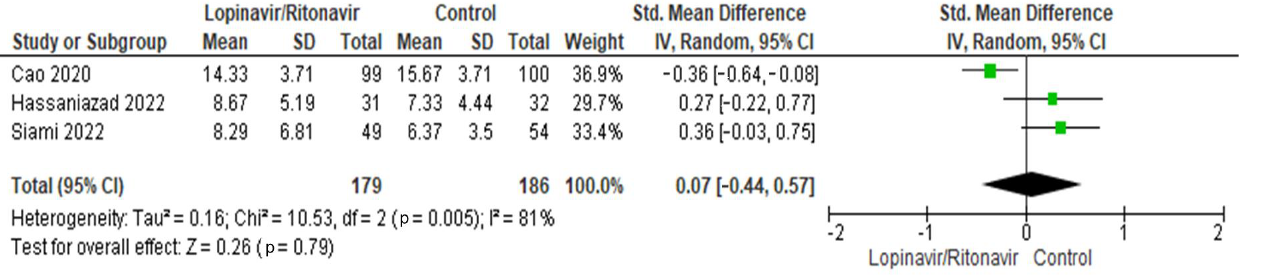
Figure 5. Forest plot analysis for length of hospital stay. The sizes of the green squares reflect the relative weight of the individual trials. The combined point estimate is shown as a black diamond. The diamond and squares (together with the 95% CIs) located beyond the vertical line (indicating the unit value) show that a result was statistically significant.